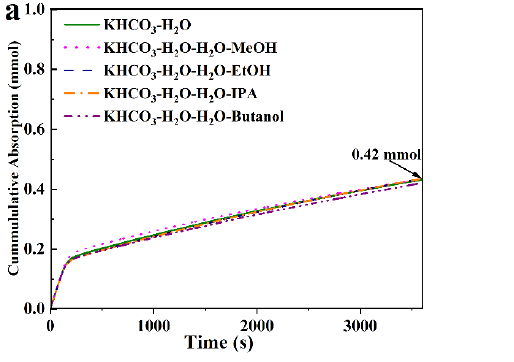
Figure 2. The effects of different alcohols on CO 2 absorption in KHCO 3 − H 2 O and KHCO 3 − H 2 O − 45 wt % alcohol solutions: ( a ) effects of alcohols on the quantities of absorbed CO 2 . ( b ) The rates of CO 2 Table 1. Summary of the effects of alcohol on CO 2 desorption with KHCO 3 − H 2 O − alcohol